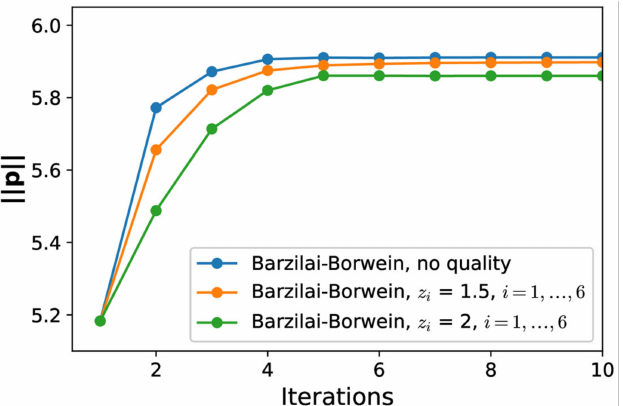
Figure 4. Convergence of the iterative optimization method with adaptive step and vertical differen- tiation products, Mesh 4.